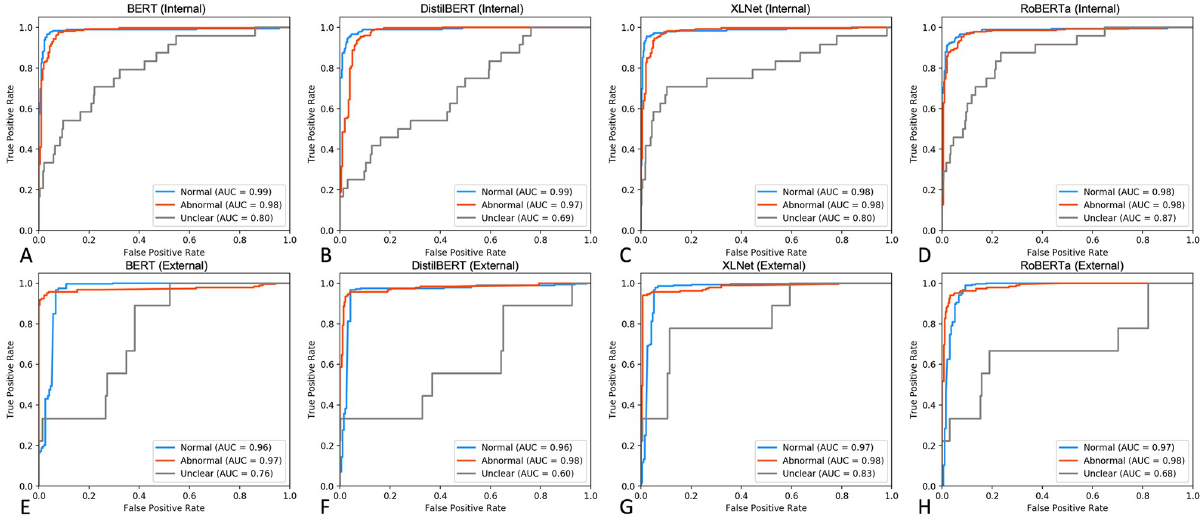
Fig 5. Performance assessment of Transformer-based classifiers on internal and external testing sets. A-D. ROC curves displaying performance metrics on an expert-labelled internal testing set (n = 329 Normal, n = 601 Abnormal, n = 35 Uncertain). E-H. ROC curves demonstrating classifier performance on the external MIMIC-CXR expert-labelled free-text reports (n = 272 Normal, n = 184 Abnormal, n = 9